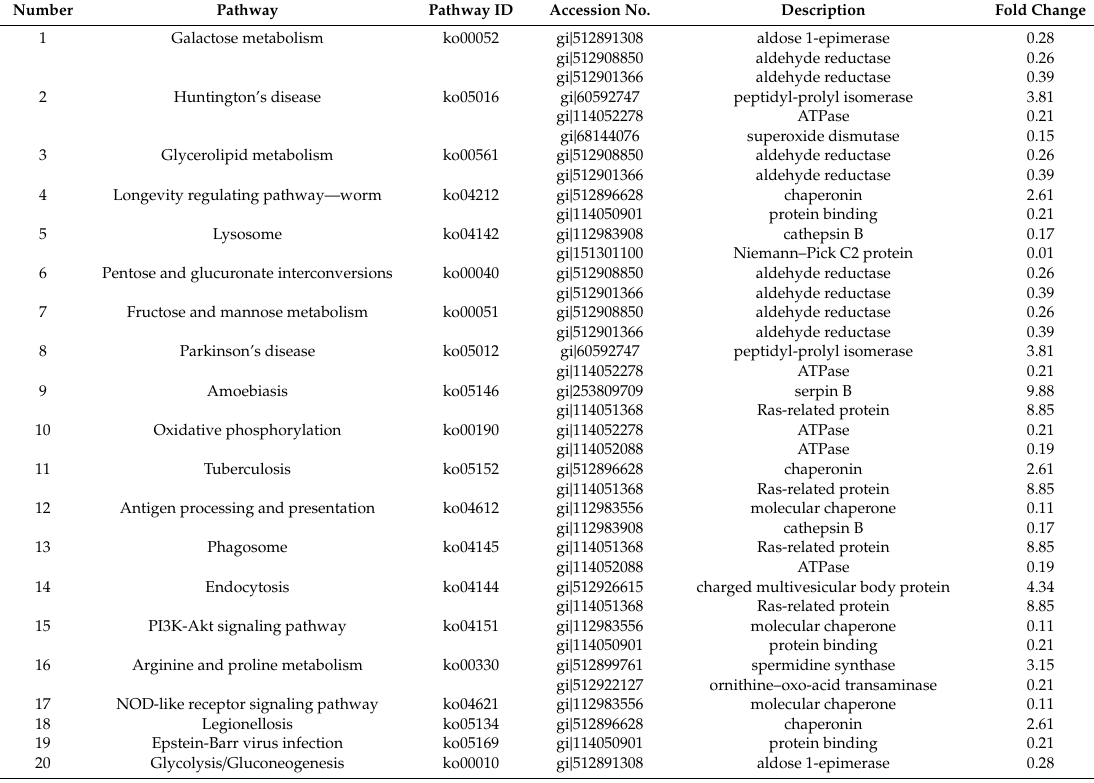
Table 2. Kyoto Encyclopedia of Genes and Genomes (KEGG) pathway enrichment analysis of